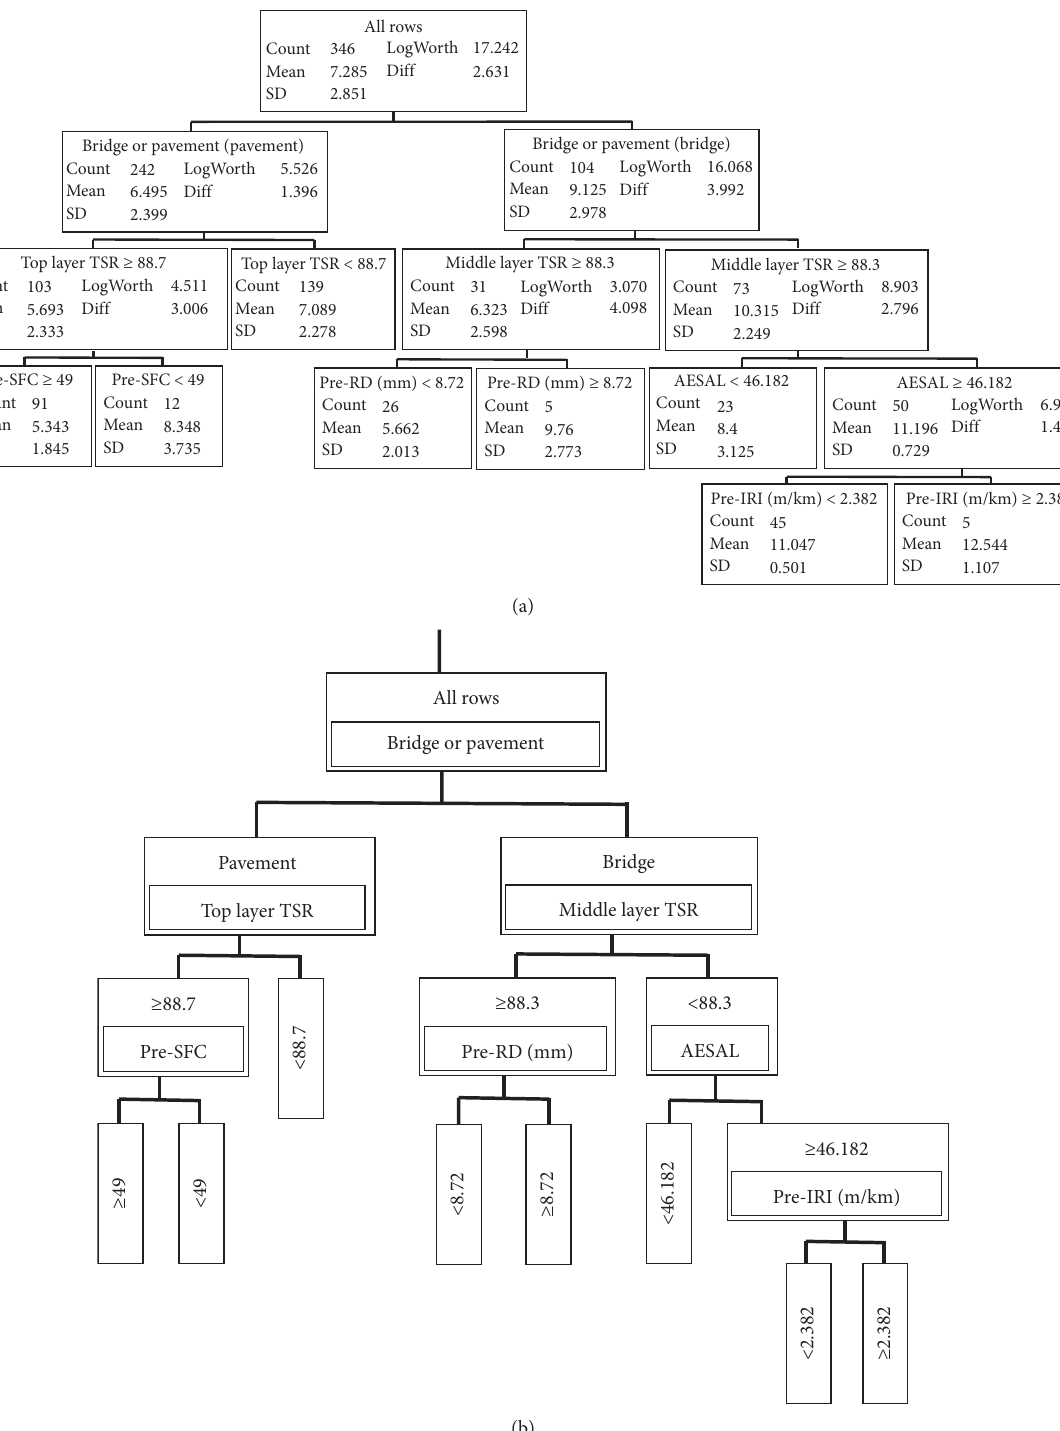
Figure 4: Results of classification tree analysis of resurfacing thickness: (a) Specific version. (b) Simplified